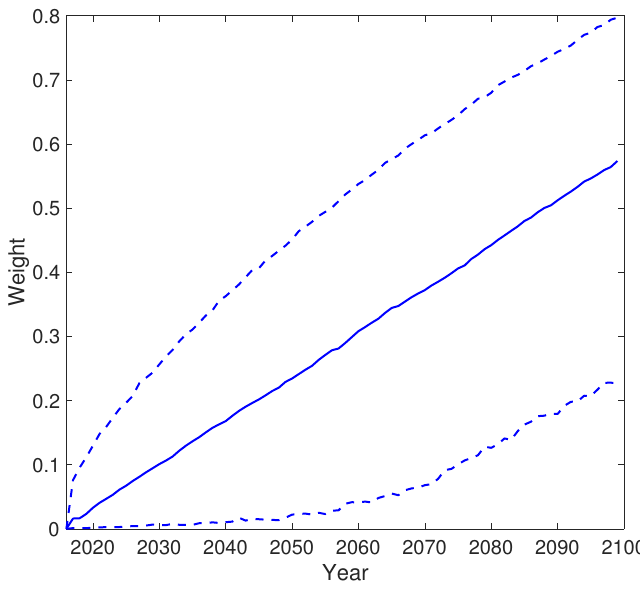
Figure A3. The 2.5%, 50%, and 97.5% quantile of the weight over time for Nigeria.